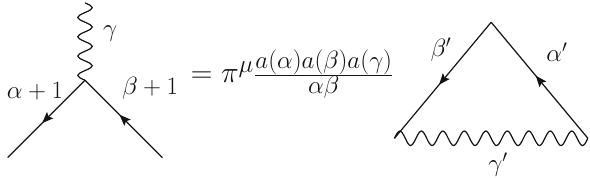
Fig. 7 Thestar-trianglerelation.Theindices α,β,γ